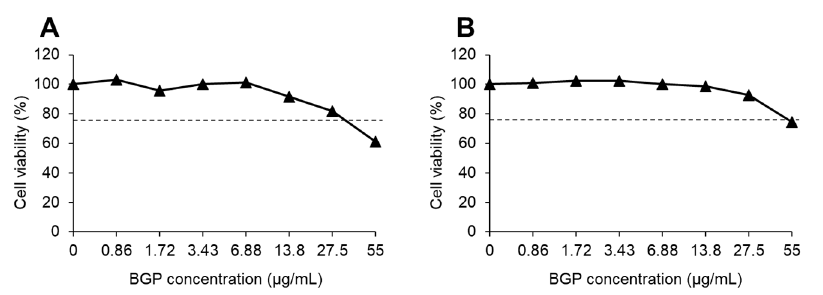
Figure 1. Viability of THP-1 cells treated with Brazilian green propolis (BGP). First experiment ( A ) and second experiment ( B ) were conducted independently, and data at each concentration were obtained from a single culture. Dashed lines indicate 75% cell viability.